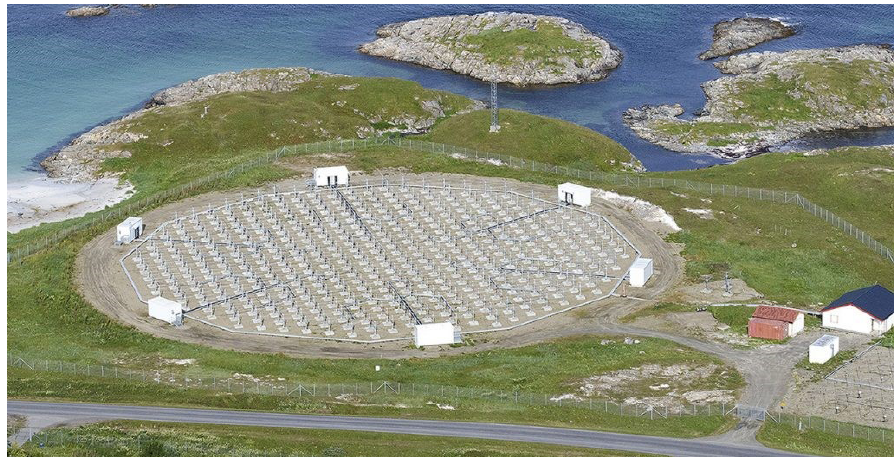
Figure 12. The MARSSY radar built by IAP. It is one of the most advanced instruments of its kind (https://www.iap-kborn.de/forschung/ abteilung-radarsondierungen/, last access: 5 December 2018).